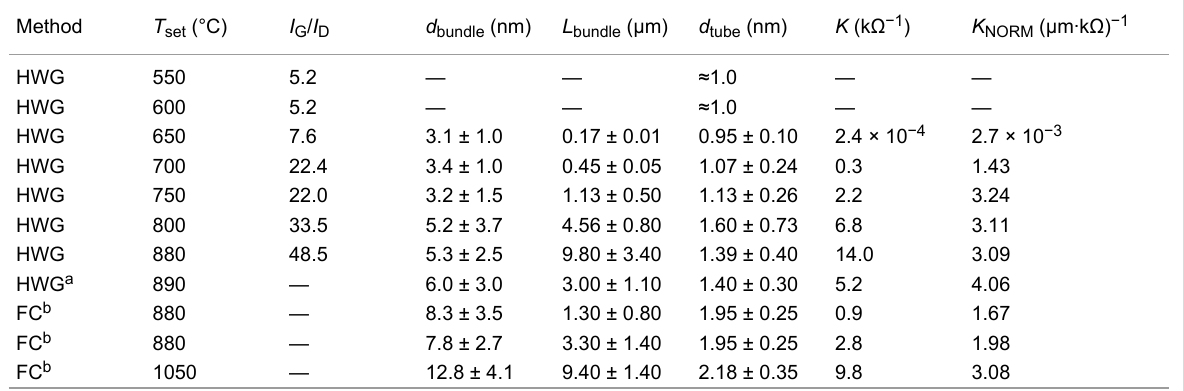
Table 1: Properties of SWCNT films fabricated in this study, along with four datasets from the literature.